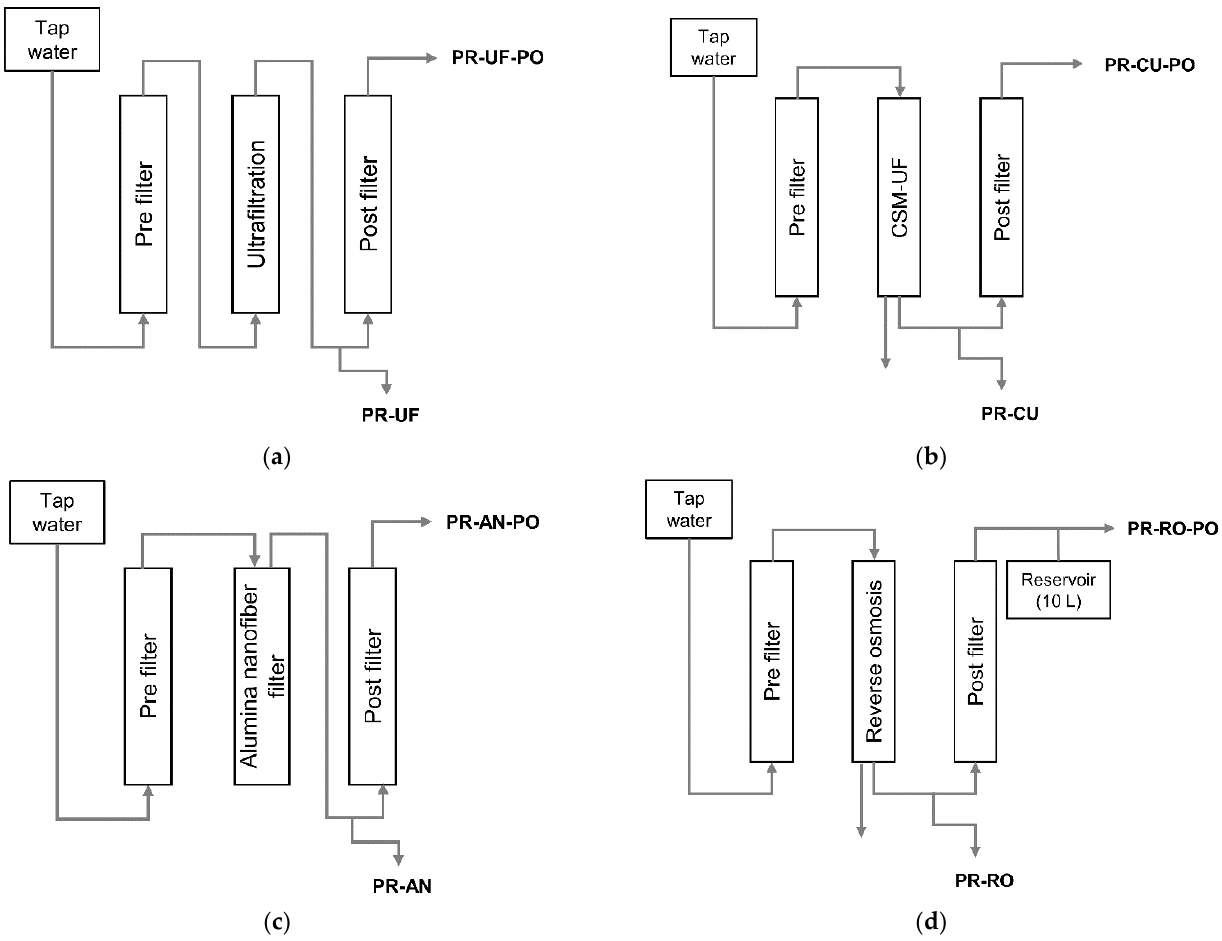
Figure 1. The point-of-use water treatment system used in this study: ( a ) ultrafiltration (UF); ( b ) CSM-ultrafiltration (CU); ( c ) alumina nanofiber filter (AN); and ( d ) reverse osmosis filter (RO). PR and PR mean pre-carbon and post-carbon filter, respectively.